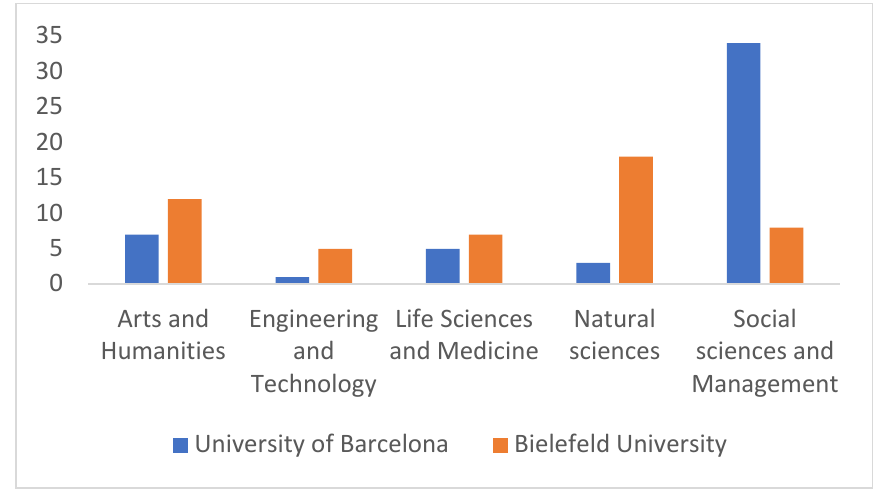
Figure 11. Ratio of studying areas of respondents. The age range of respondents varies from 18 to 26 for University of Barcelona and 18 to 30 for Bielefeld University. The most frequent age is 21 for both Universities. One of the main indicators for further research is the subscription on the official account of the university on social media. At the University of Barcelona, students are mostly not subscribed, while at Bielefeld University 62% are subscribed (see Figure 12).